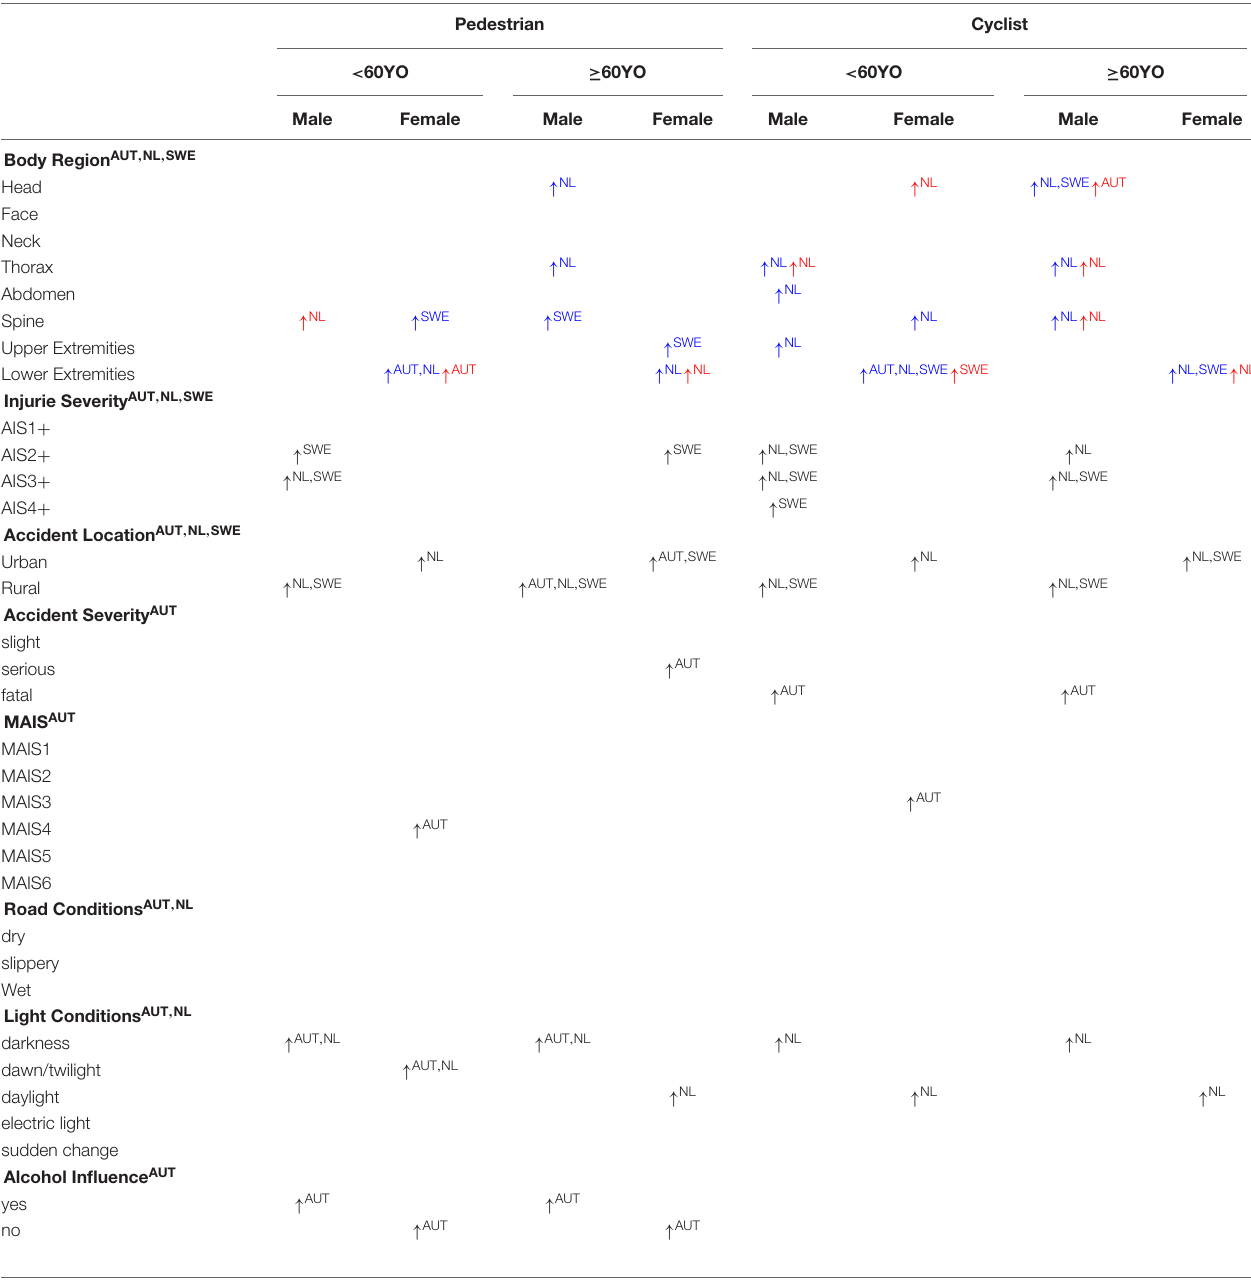
TABLE 11 | Summary of all significant differences for different body regions and accident parameters for pedestrians and cyclists for Austria (AUT), Netherlands (NL), and Sweden (SWE). Pedestrian Cyclist <